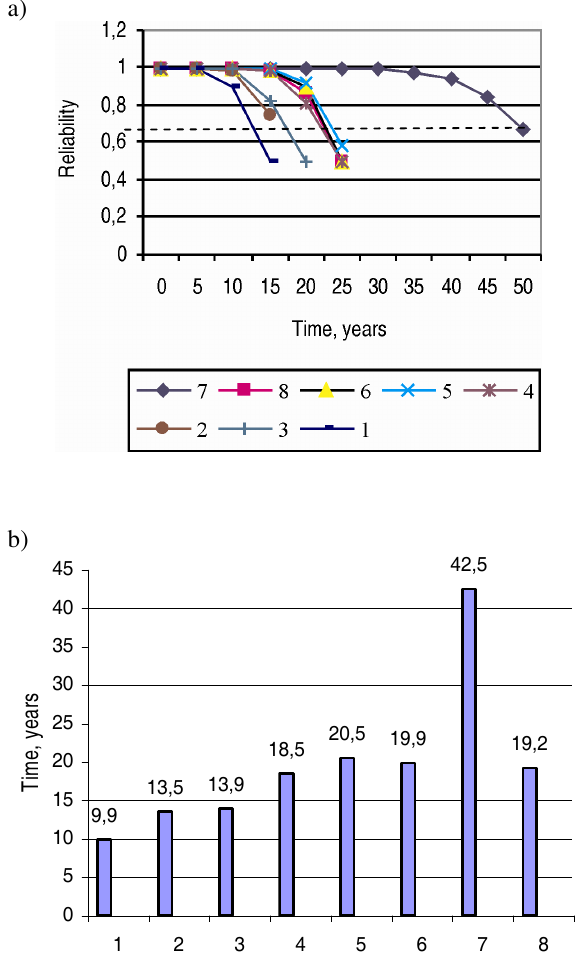
Fig 1 . Probability of serviceability (a) and service life (b) of polymer coatings in different exposure conditions: 1 − H 2 O; 2 − H 2 SO 4 10 %; 3 − H 2 SO 4 30 %; 4 − Na 2 SO 3 2 %; 5 − NaOH 10 %; 6 − Petrol; 7 − NaCl +20 °C;